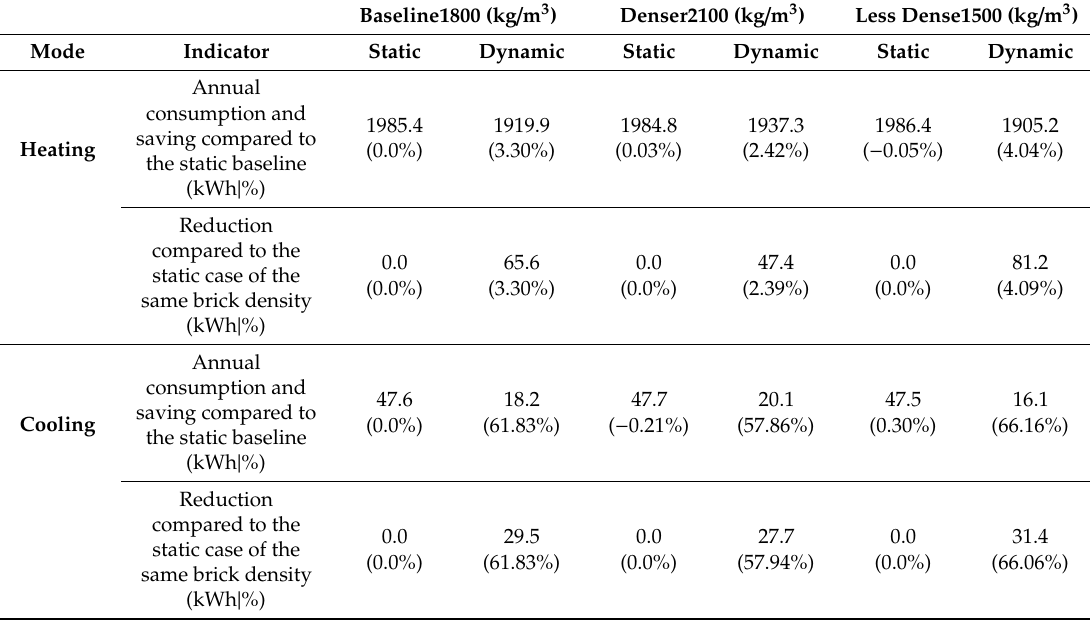
Table 8. Comparison of annual heating and cooling energy consumption for various densities of the exterior brick layer of the walls of the typical Belgian